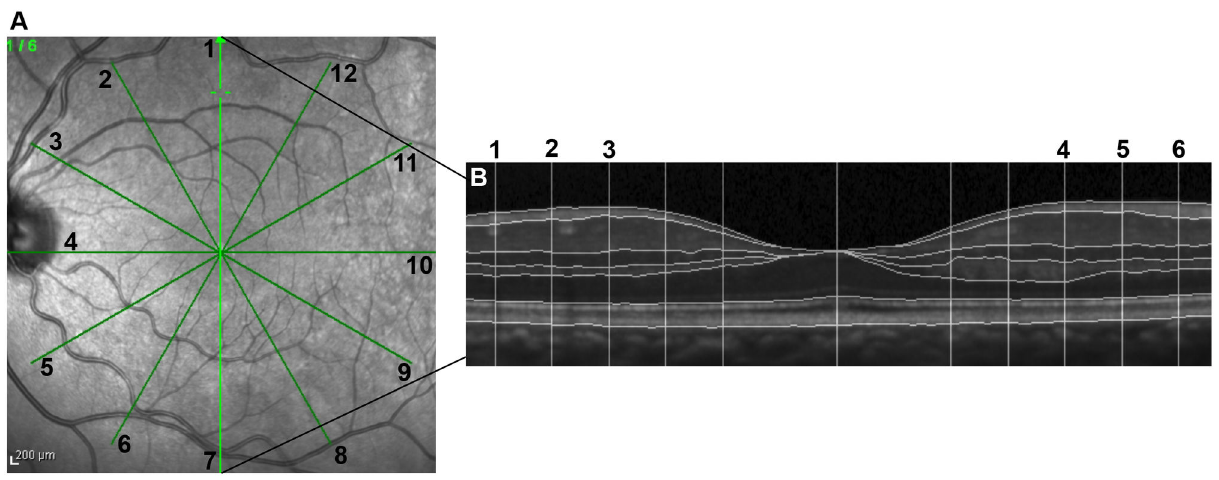
Figure 1. OCT segmentation pattern. A. Fundus view: OCT segmentation along 12 radial lines through the central fovea. B. Cross-sectional view: Along each scan line, the thickness of each retinal layer was measured at 6 different points (3 points along each radial line). The 5 points closest to the fovea were not included in the analysis due to variability in automated retinal layer segmentation in this area as a result of indistinct